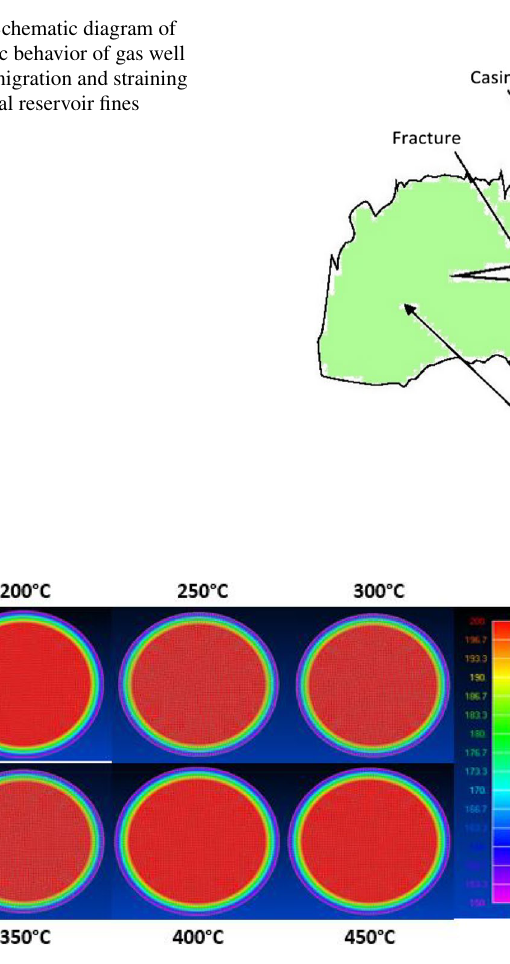
Fig. 5 Well temperature variation at different steady-state thermal regimes (for the view of figures with labels and coordinates, a reader is advised to see Online Appendix